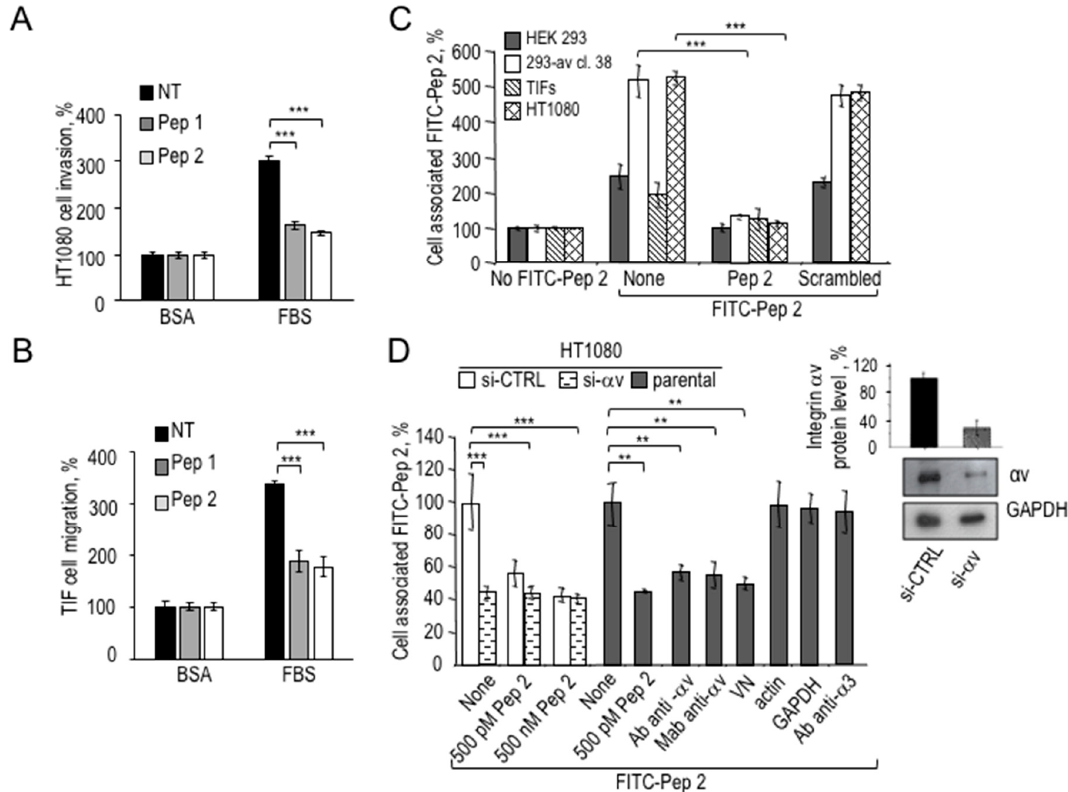
Figure 4. Pep 1 and Pep 2 peptides inhibit HT1080 invasion by binding to α v integrin subunit. ( A ) 2 × 10 4 HT1080 cells/sample or ( B ) 5 × 10 4 /sample TIF fibroblasts were pre ‐ incubated with or without 100 nM Pep 1 or Pep 2 for 1 h at 37 °C and then assayed in Boyden chambers at 37 °C, either for FBS ‐ dependent invasion on matrigel for 5 h ( A ) or for FBS ‐ dependent migration for 3 h ( B ). Data are expressed as in the legend to Figure 3D (*** p < 0.001, Student’s t ‐ test). ( C ) 2 × 10 6 HEK ‐ 293 cells, or HEK ‐ 293 ‐α v ‐ 38, TIF or HT1080 cells were pre ‐ incubated for 30 min at 4 °C with an excess of unlabeled Pep 2 or scrambled peptides (500 nM) and exposed to 50 nM FITC ‐ Pep 2 for 2 h at 4 °C. Cell surface ‐ associated fluorescence, as percentage of the samples with no FITC ‐ Pep 2, is shown. Data represent a mean of three independent experiments performed in duplicate (*** p < 0.001, Student’s t ‐ test). ( D ) α v integrin mRNA (si- α v). The e ffi ciency of silencing was assessed by Western Blot using polyclonal antibody or monoclonal anti ‐ GAPDH as loading control and quantified by Image J (inset). The whole